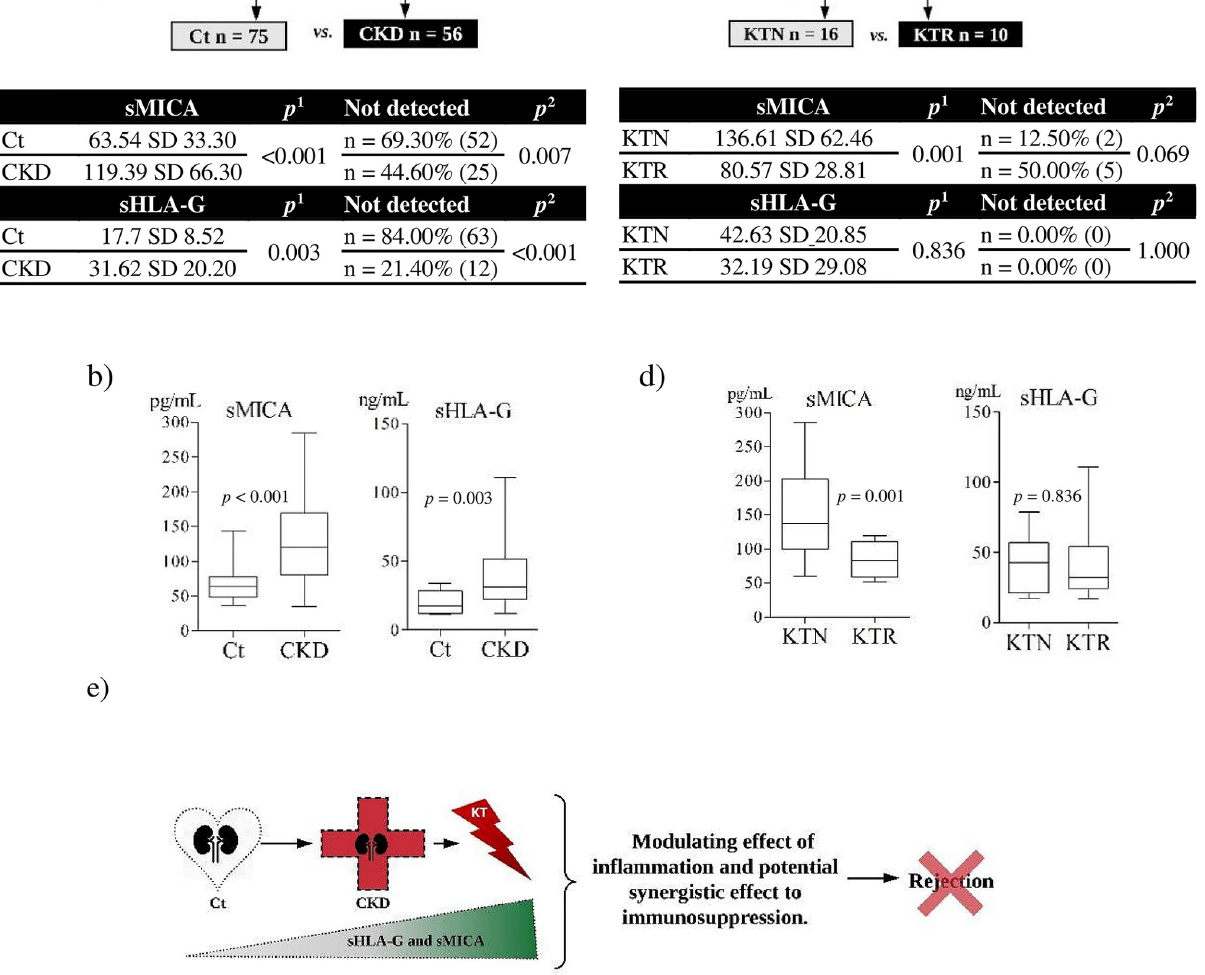
PLOS ONE | https://doi.org/10.1371/journal.pone.0212750 February 22,